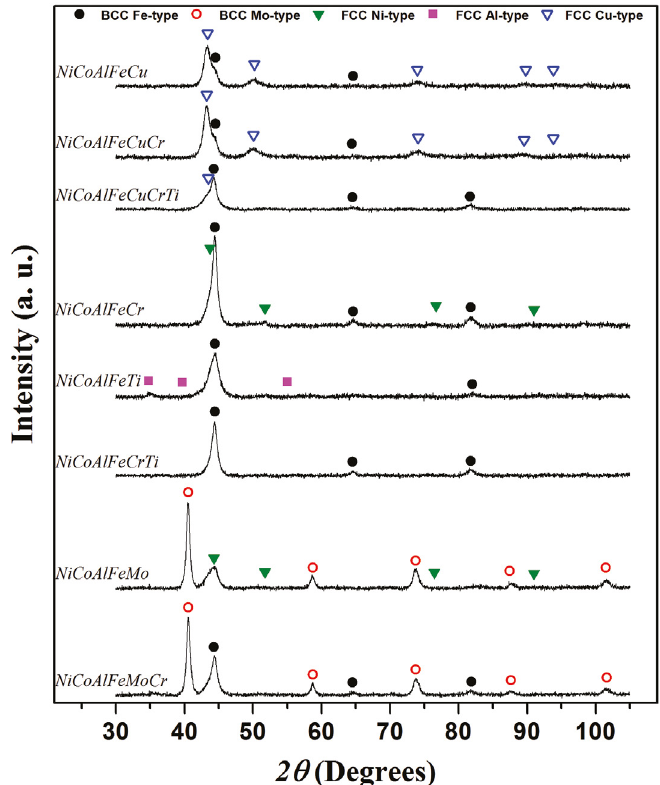
Figure 8: XRD patterns of powders after 10 h of milling showing the structural evolution as a function of the chemical composition.